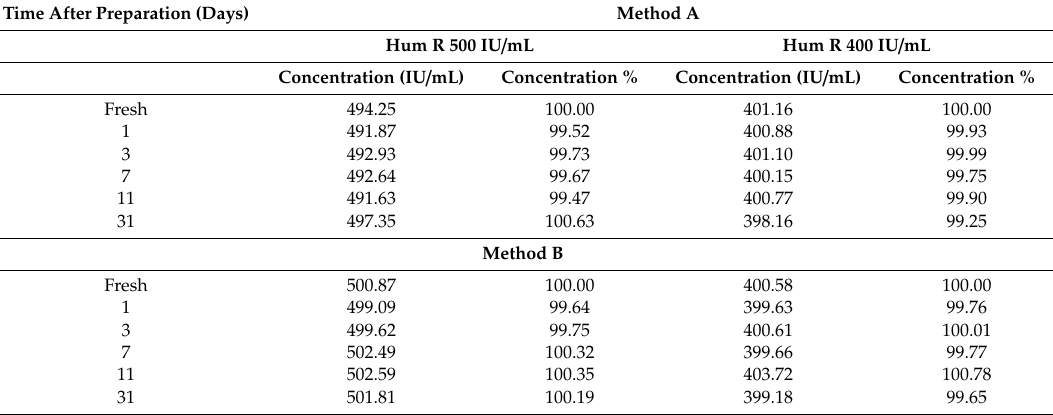
Table 3. Stability data for Hum R insulin samples stored at 20 ◦ C for 31 days using methods A and B.